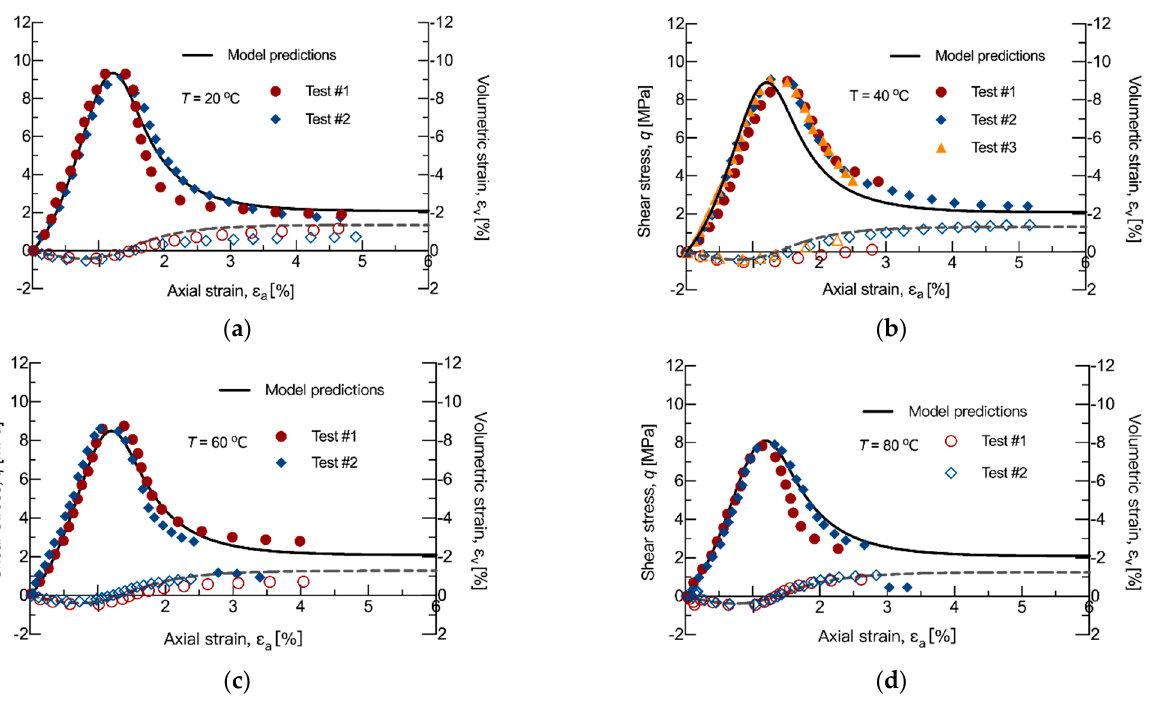
Figure 7. Experimental data and model predictions: ( a ) T = 20 °C; ( b ) T = 40 °C; ( c ) T = 60 °C; ( d ) T = 80 °C.